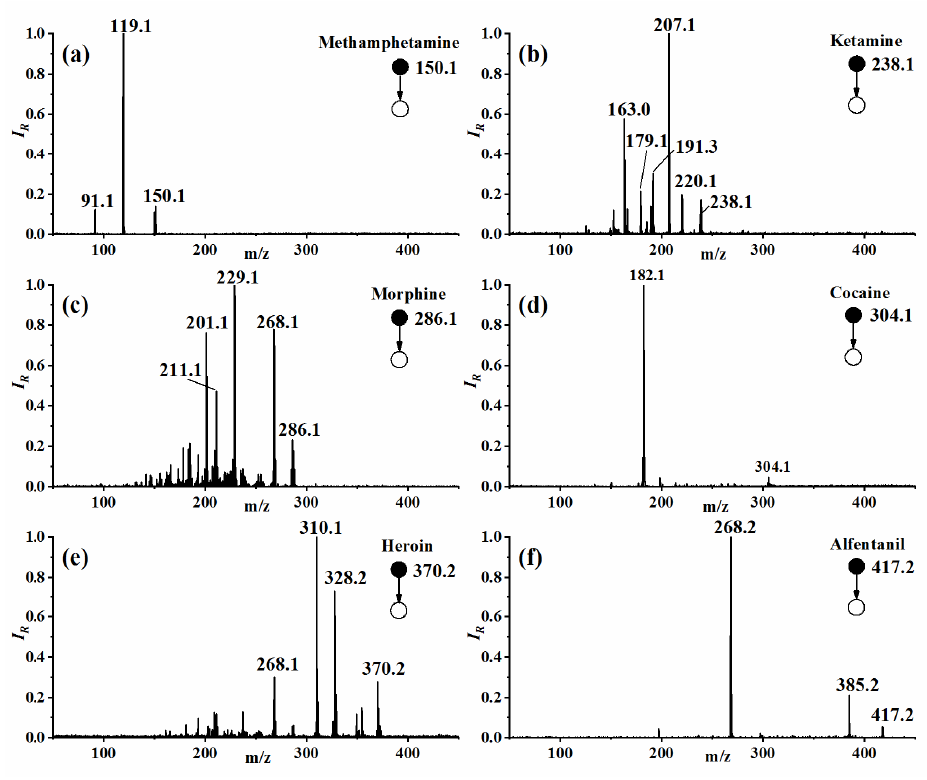
Figure 3. MS/MS spectra of six typical narcotic samples. (a) Methamphetamine; (b) Ketamine; (c) Morphine; (d) Cocaine; (e) Heroin; (f) Alfentanil.